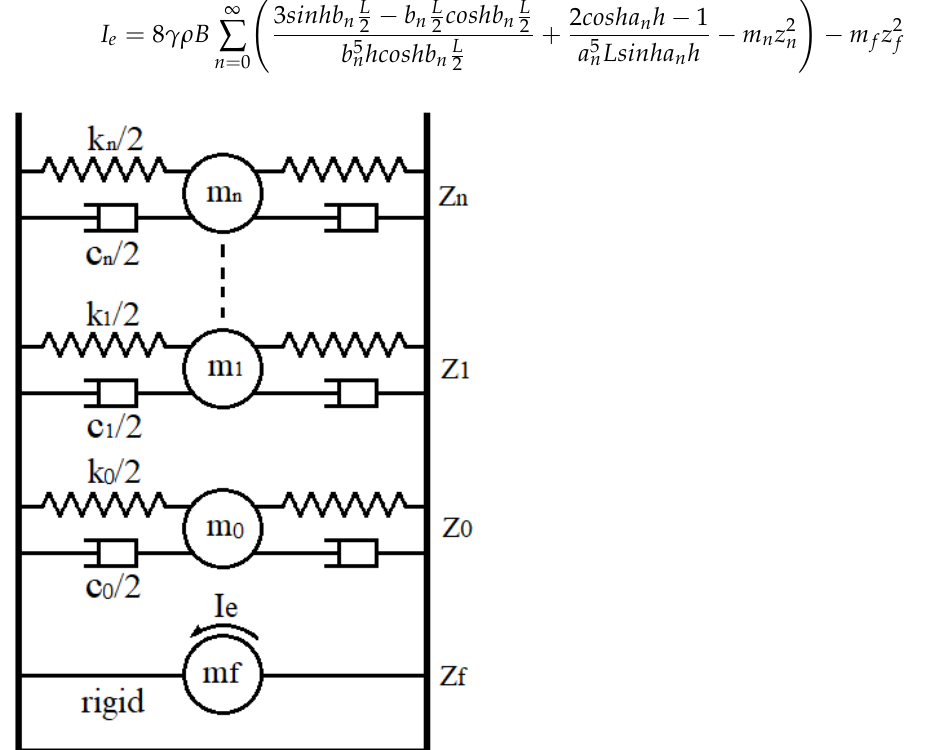
Figure 2. The schematic diagram of the equivalent mechanical model of a water tank filled with porous media.